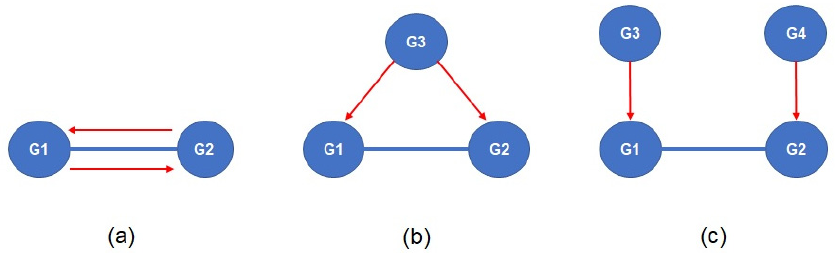
Figure 1. Interpretation of significant co-expression between G1 and G2. The figures illustrate possible scenarios of a co-expression relationship. ( a ) One gene directly regulates the expression of the other gene. ( b ) G3 is a common gene that regulates the expression of G1 and G2 simultaneously. ( c ) G1 and G2 are regulated by G3 and G4, respectively. The red lines indicate regulatory relationships. GCNs have revealed functional implications of GRNs in cancers. In particular, when combined with an enrichment test using biological knowledge, such as pathway or gene ontology (GO), GCNs enabled identification of essential biological mechanisms that are consistent with the current knowledge about the molecular biology of cancer development and progression [14]. For example, Aggarwal et al. identified a gastrome, which is a functional module defined by meta-analysis of co-expression analysis of four different gastric cancer datasets [15]. In this analysis, they clustered the network of significant co- expressions and identified the functional implications of the clusters using GO enrichment, which is tested based on the hypergeometric distribution. This gastrome consisted of genes that are related to cell proliferation, adhesion, and immune responses, which are closely related to cancer pathophysiology. Moreover, they found a novel interaction between PLA2G2A and EphB2 . Although this study identified both functional modules and regulatory relationships between individual gene pairs, most other studies only reported functional modules of cancers using co-expression analysis [17–19]. In addition to using the CC for the estimation of GCNs, some modifications are applied for better estimation of co-expression relationships [20–34]. Weighted gene co-expression analysis (WGCNA) is one of the most widely used methods. It uses signed co-expression measure between genes x and y using the following equation.